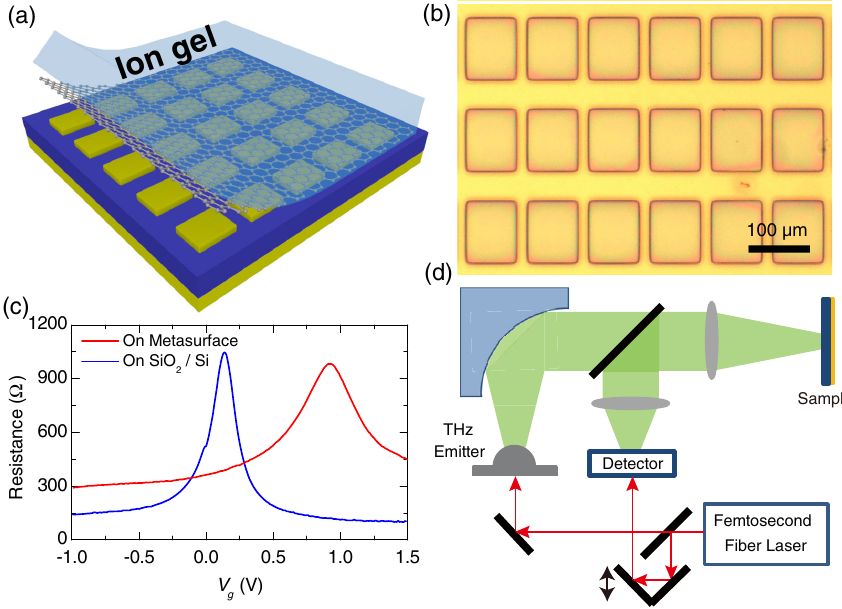
FIG. 1. Device geometry and experimental setup. (a) A schematic of the structure of the proposed device. The metasurface consists of an array of Al mesas and a continuous Al film (yellow) separated by an SU8 spacer (blue). CVD-grown monolayer graphene is transferred to the top of the metasurface and subsequently covered by a layer of gel-like ion liquid. The gate voltage applied between graphene and a top gate (not shown) controls the doping level of graphene. (b) An optical image of a typical device viewed from the top. (c) The gate-dependent resistance of CVD-grown graphene transferred to a silicon wafer (blue curve) and the metasurface (red curve). (d) A schematic of the THz time-domain spectroscopy measurement [Fig. 1(b)] on the layer by using standard optical lithog- raphy. The Al plane and the mesa array (both with a thickness of approximately 50 nm) form a magnetic